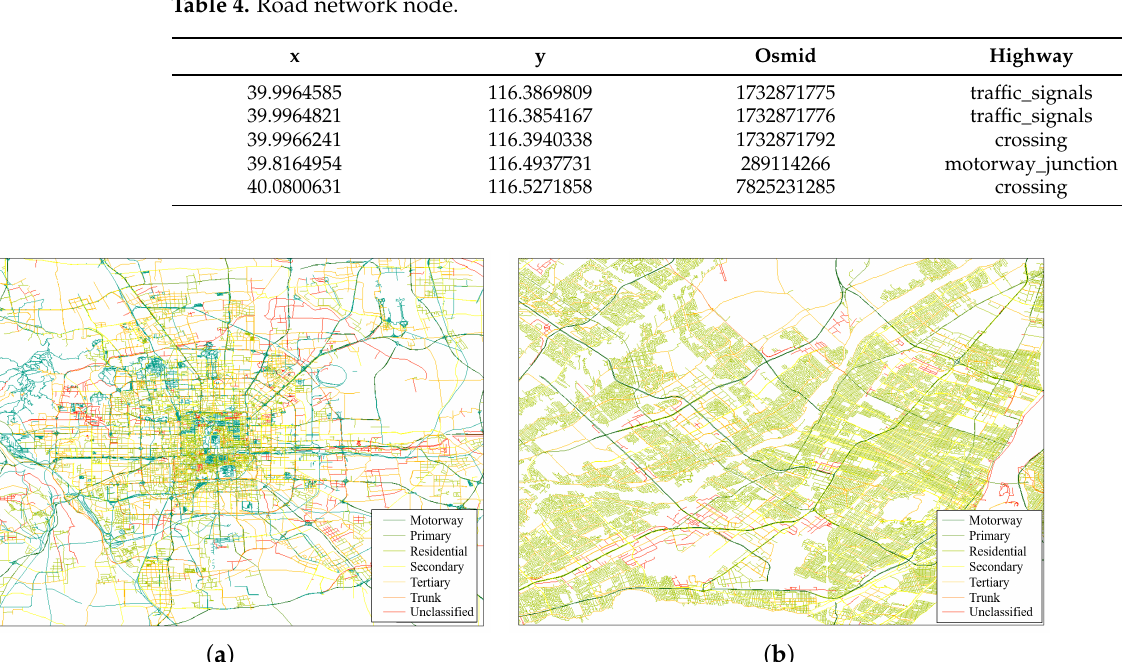
Figure 4. The road networks of Beijing and Montreal. ( a ) Beijing. ( b )